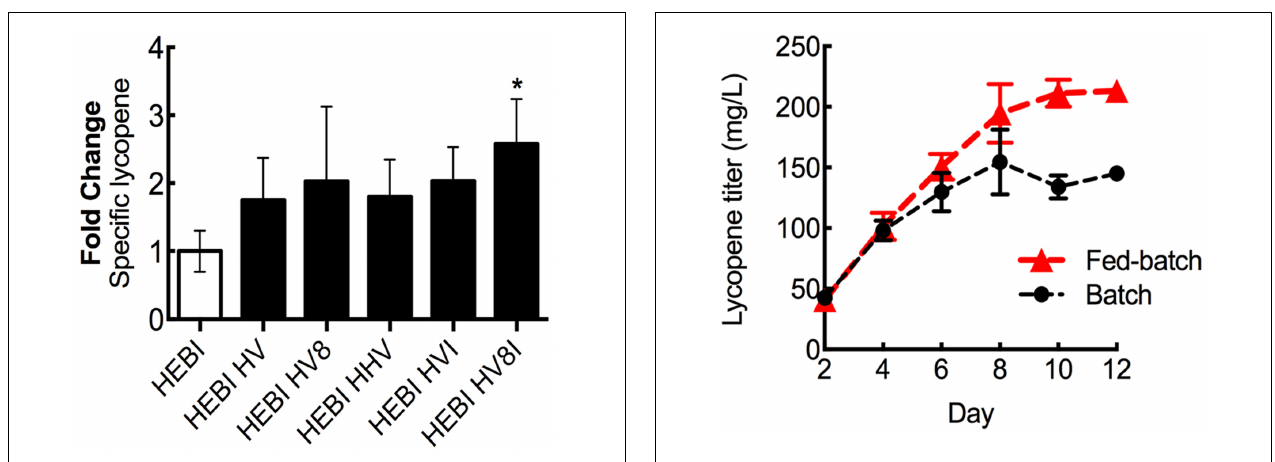
FIGURE 8 | Combing successful overexpressions to optimize lycopene production. Relative specific lycopene of strains combining successful engineering strategies to maximize lycopene production in 4-day shake flask cultures. Strains were grown for 4 days in 25 mL of YPD10 at 30 ◦ C in baffled shake flasks. Bars and error bars represent the mean and standard deviation, respectively, of biological triplicates. Statistical significance from the HEBI strain is indicated by “ ∗ ”. The HEBI strain produced 2.0 ± 0.5 mg lycopene/g DCW. HV8I indicates the following overexpressions in the HEBI background: H = HMG1, V = MVD1, 8 = ERG8, I = CrtI. Names with multiple copies of a given letter indicate multiple overexpressions of the indicated gene.